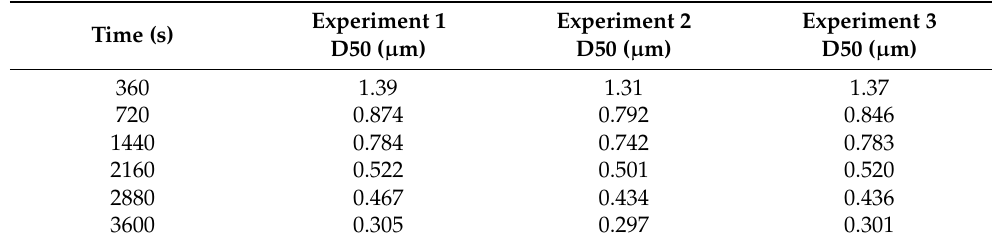
Table 2. Discrete experimental sampling values used as training data for the ANN. These values represent three performed experiments using Itraconazole as API and Poloxamer-188 as stabilizer [19], which proved to be the most suitable after the Gibbs energy